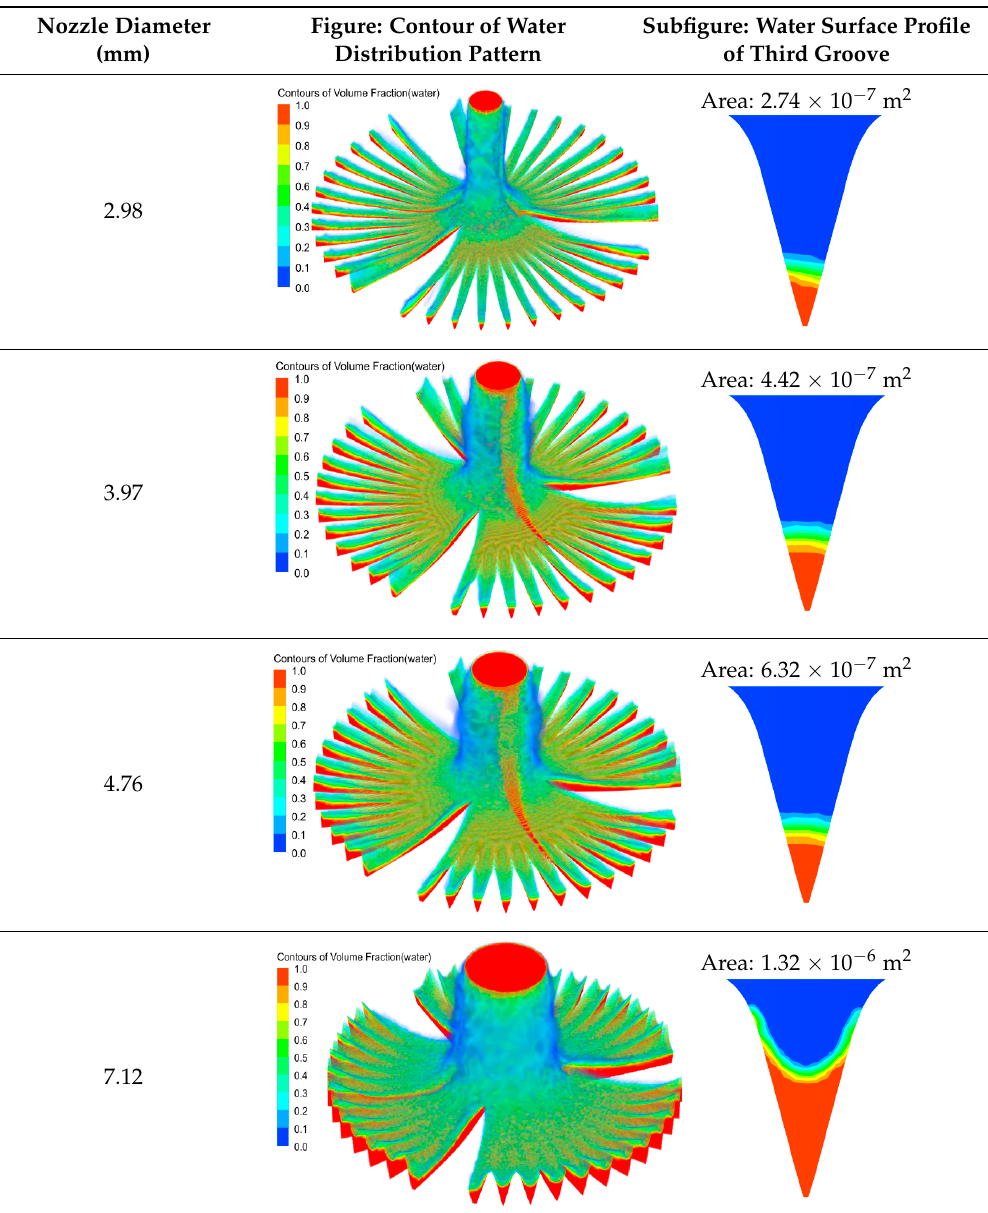
Table 3. Contours of the water fraction at 200 kPa of working pressure. Figure: Contour of Water